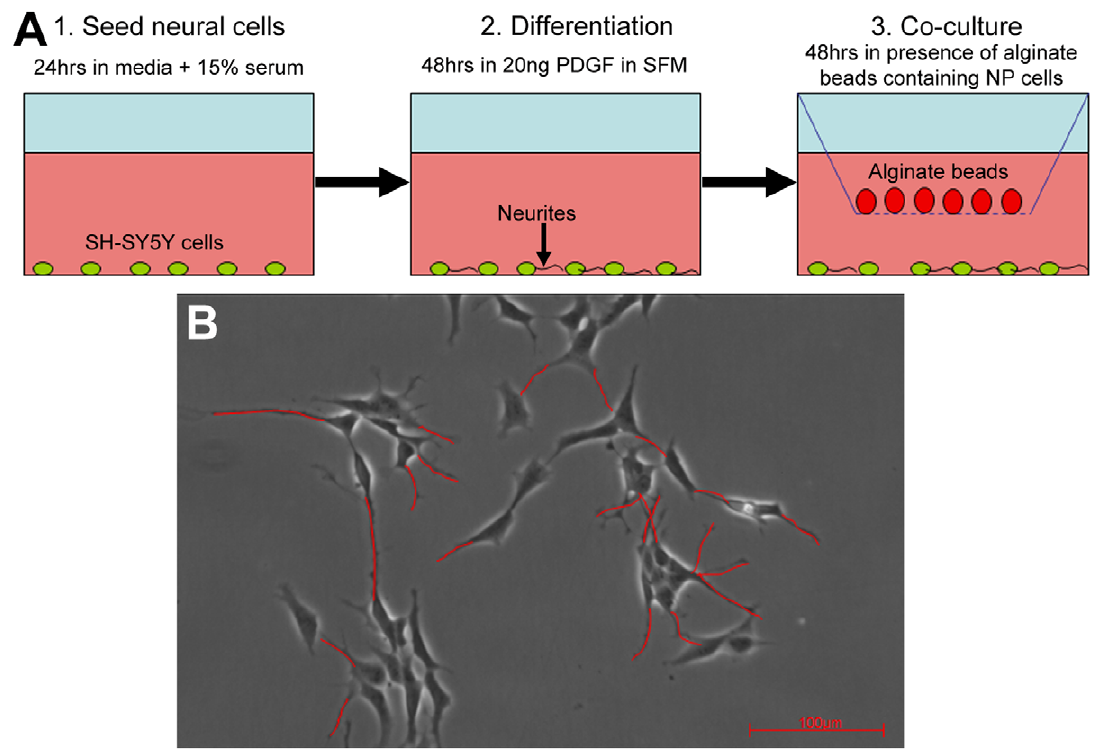
Figure 1. Schematic overview of experimental setup and analysis. (A) Diagram illustrating the co-culture model. (B) Measurement of neurite outgrowth from SH-SY5Y cells. Neurites were traced (red lines) and the mean neurite length measured for the total number of cells in each field of view. The mean percentage number of neurite expressing cells in each field of view was also calculated.